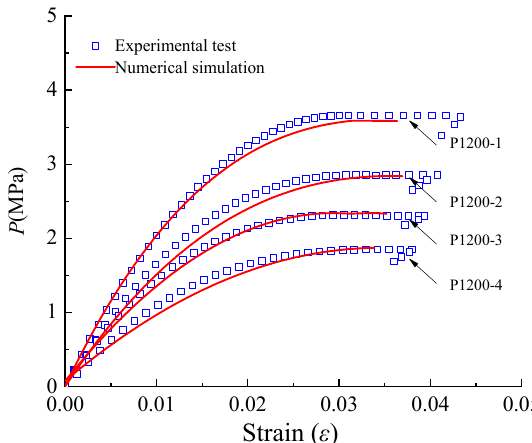
Figure 19. Numerical and experimental stress–strain curves.